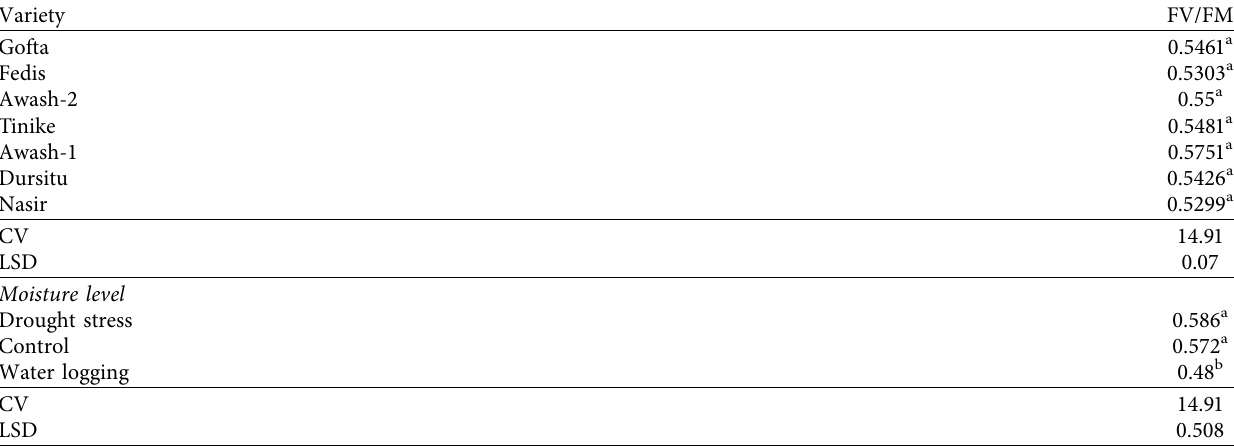
Table 7: Main efects of common bean varieties and soil irrigation interval on leaf chlorophyll fuorescence under lath house from June to September, 2020.